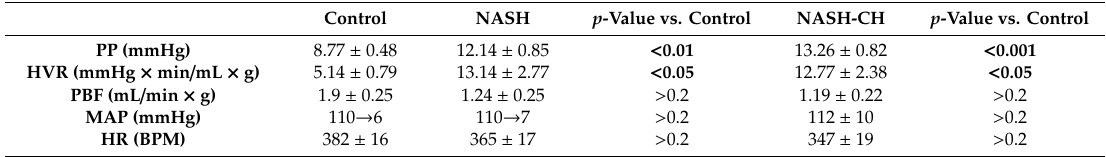
Table 1. Hemodynamic characteristics in control and NASH rats. Control NASH p -Value vs. Control NASH-CH p -Value vs.